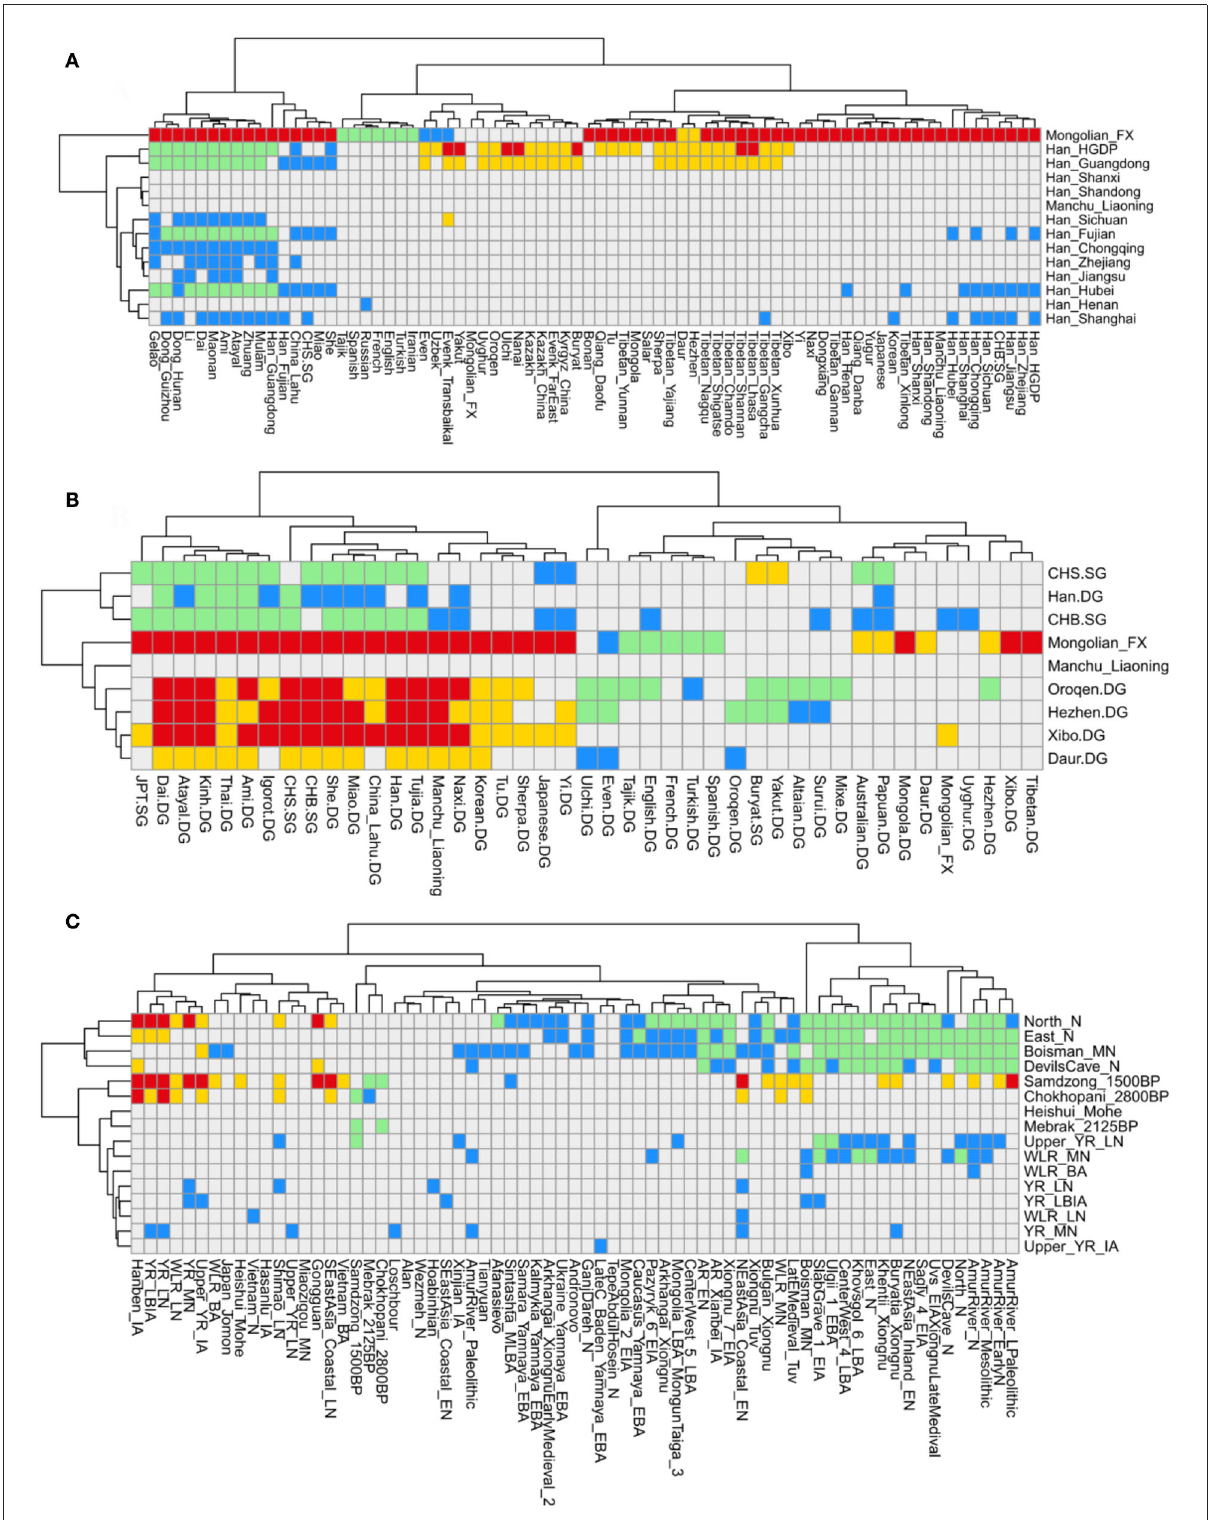
FIGURE5 Shared allele and gene flow direction explored via f 4 -statistics analysis. (A) f 4 (Modern population1, Han_Liaoning; Modern population2, Mbuti) based on the “Merged-HO” dataset; (B) f 4 (Modern population1, Han_Liaoning; Modern population2, Mbuti) based on the “Merged-1240K” dataset; (C) f 4 (Ancient population1, Han_Liaoning; Ancient population2, Mbuti) based on the “Merged-1240K”